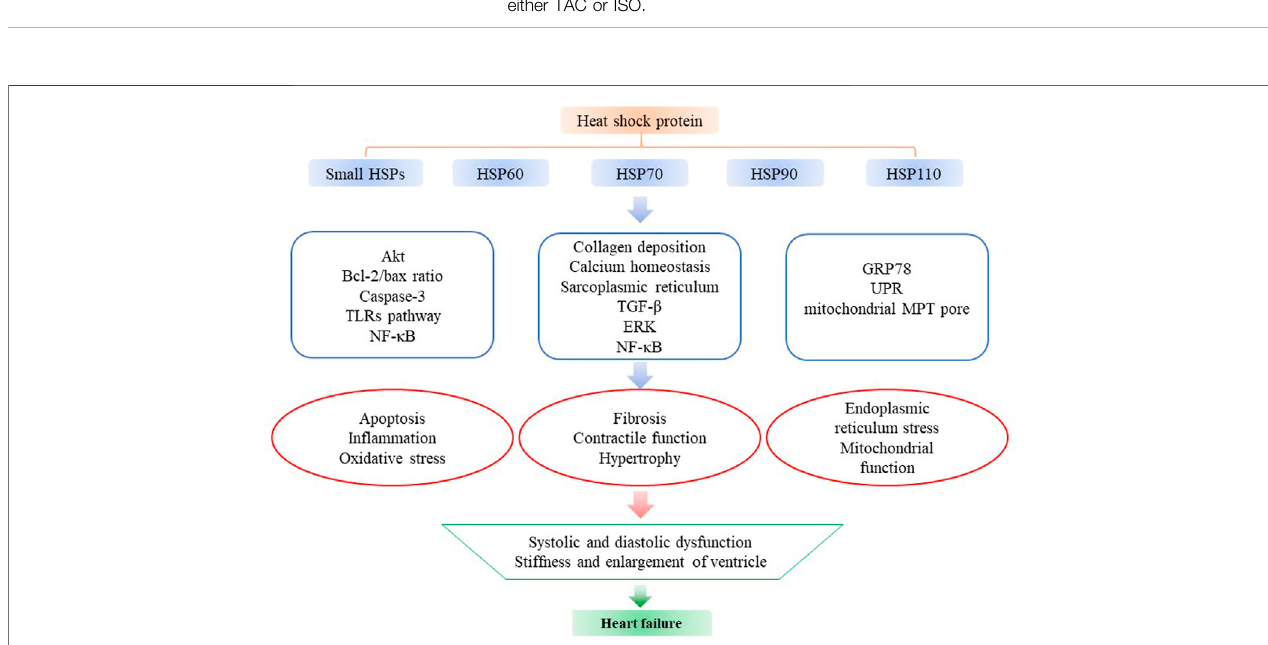
FIGURE 1 | The functions of heat shock proteins in HF. Small HSPs (HSP27, HSP20, HO-1), HSP60, HSP70, HSP90, and HSP110 are the most studied HSPs in HF. They can affect apoptosis, in fl ammation, oxidative stress, fi brosis, contractile function, hypertrophy, ER stress and mitochondrial function by regulating multiple pathways like Akt, caspase-3, ERK and various cellular functions like ER and mitochondria in the progression of HF, including modulating the systolic and diastolic function and the stiffness and enlargement of ventricle.